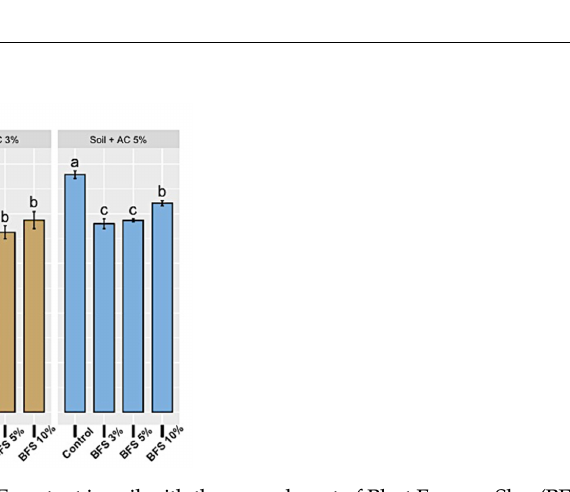
Figure 8. PTE content in roots and aerial parts of plants with the amendment of Blast Furnace Slag (BFS) and Activated Carbon (AC).